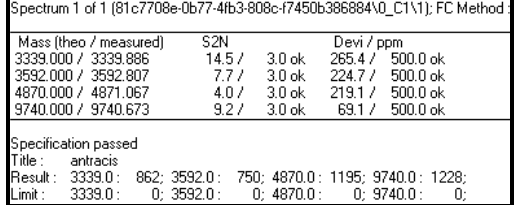
Figure 6. Result of FlexAnalysis algorithm for B. anthracis species. If all the characteristic ion peaks are found in the experimental spectrum considered, the specification is passed and the correct and unambiguous identification at species level is possible.